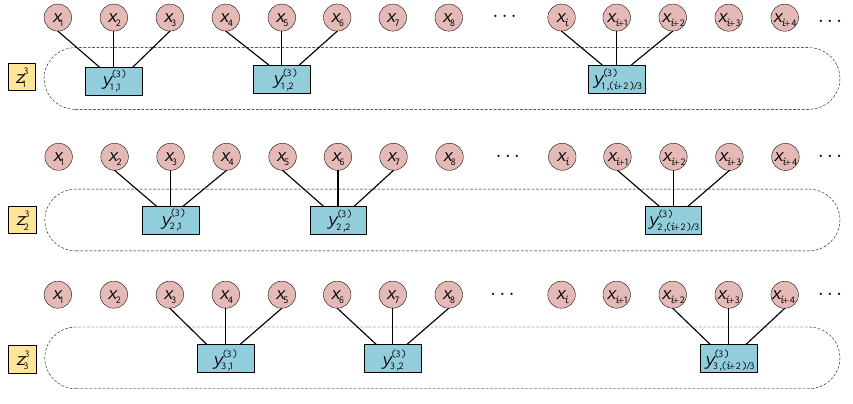
Figure 1. Improved coarse-graining process (with 3 = ).